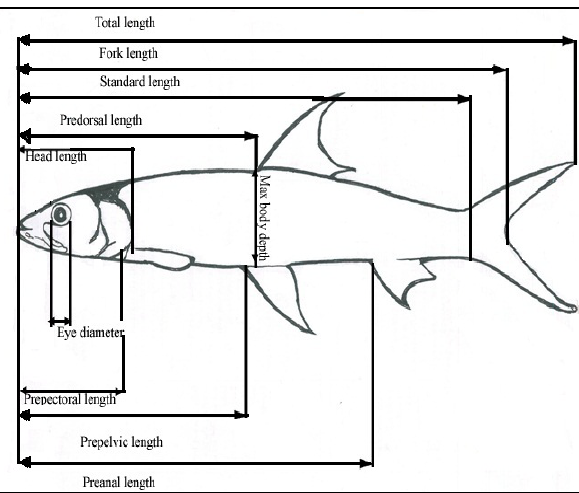
Fig. 2. Schematic diagram of fish showing superficial landmark points used in measuring morphometric characters within the